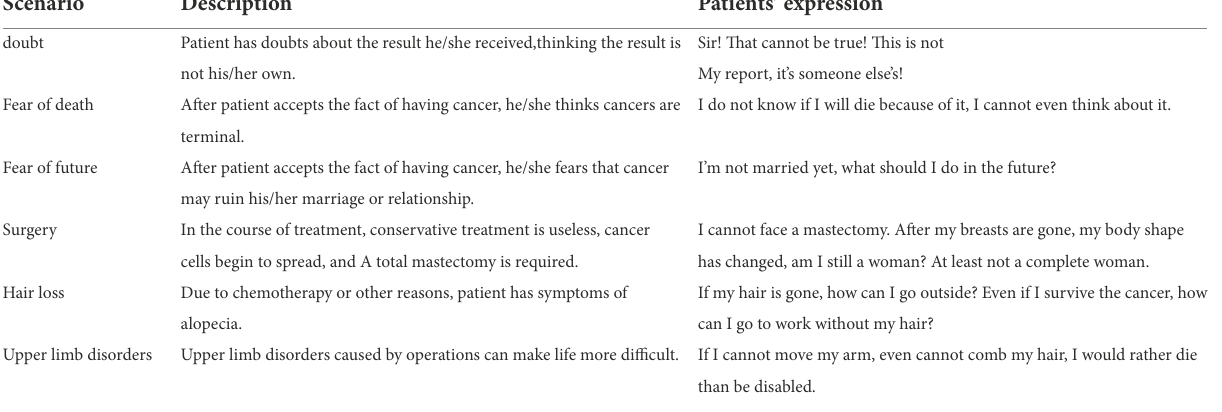
TABLE 2 Description of scenarios and patient cues and concerns.